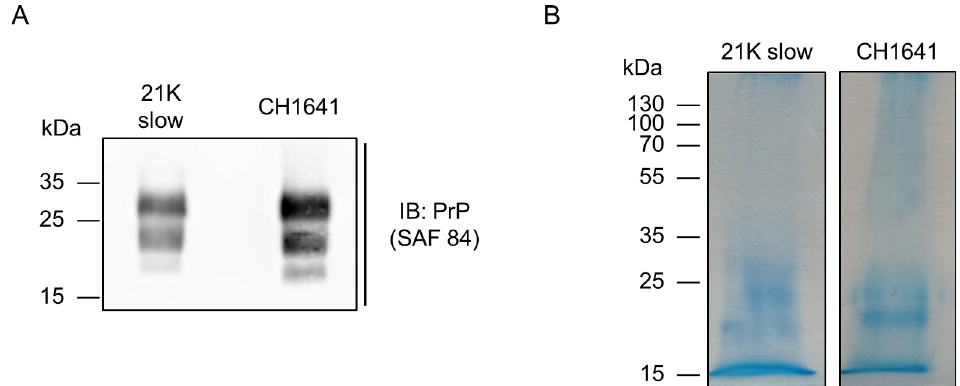
Fig 1. Results of PrP Sc isolation. A) Immunoblot of PrP Sc from 21K slow and CH1641 prion strains. B) Coomassie- stained gels of purified PrP Sc 21K slow and CH1641 strains.